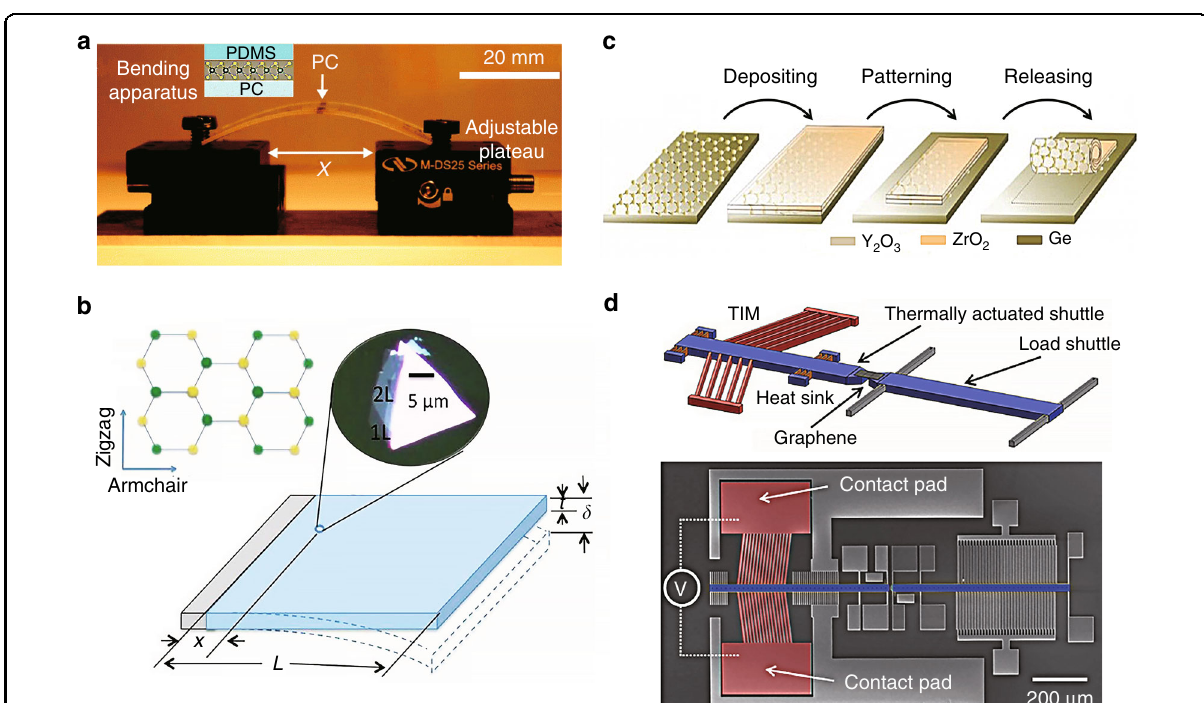
Fig. 7 Bending and elongation for generating homogenous uniaxial strain. a Experimental setup for two-point bending. The insert shows a PC- MoSe 2 -PDMS stack created by placing a viscoelastic (PDMS) stamp carrying exfoliated MoSe 2 upside down onto a polycarbonate (PC) substrate 115 . b Schematic diagram of cantilever bending where the (1L or 2L) MoS 2 sample is placed near the fi xed edge of the fl exible PMMA substrate (see the inset) 29 . c Schematic of rolling two transparent oxide layers stacked on a Ge substrate 118 . d Schematic of a MEMS device for generating large strains in graphene (upper panel) and its SEM micrograph (lower panel) 119 . Reprinted a from ref. 115 . Published by The Royal Society of Chemistry. Reprinted b with permission from ref. 29 . Copyright (2013) American Chemical Society. Reprinted c from ref. 118 with permission from Wiley. Adapted d